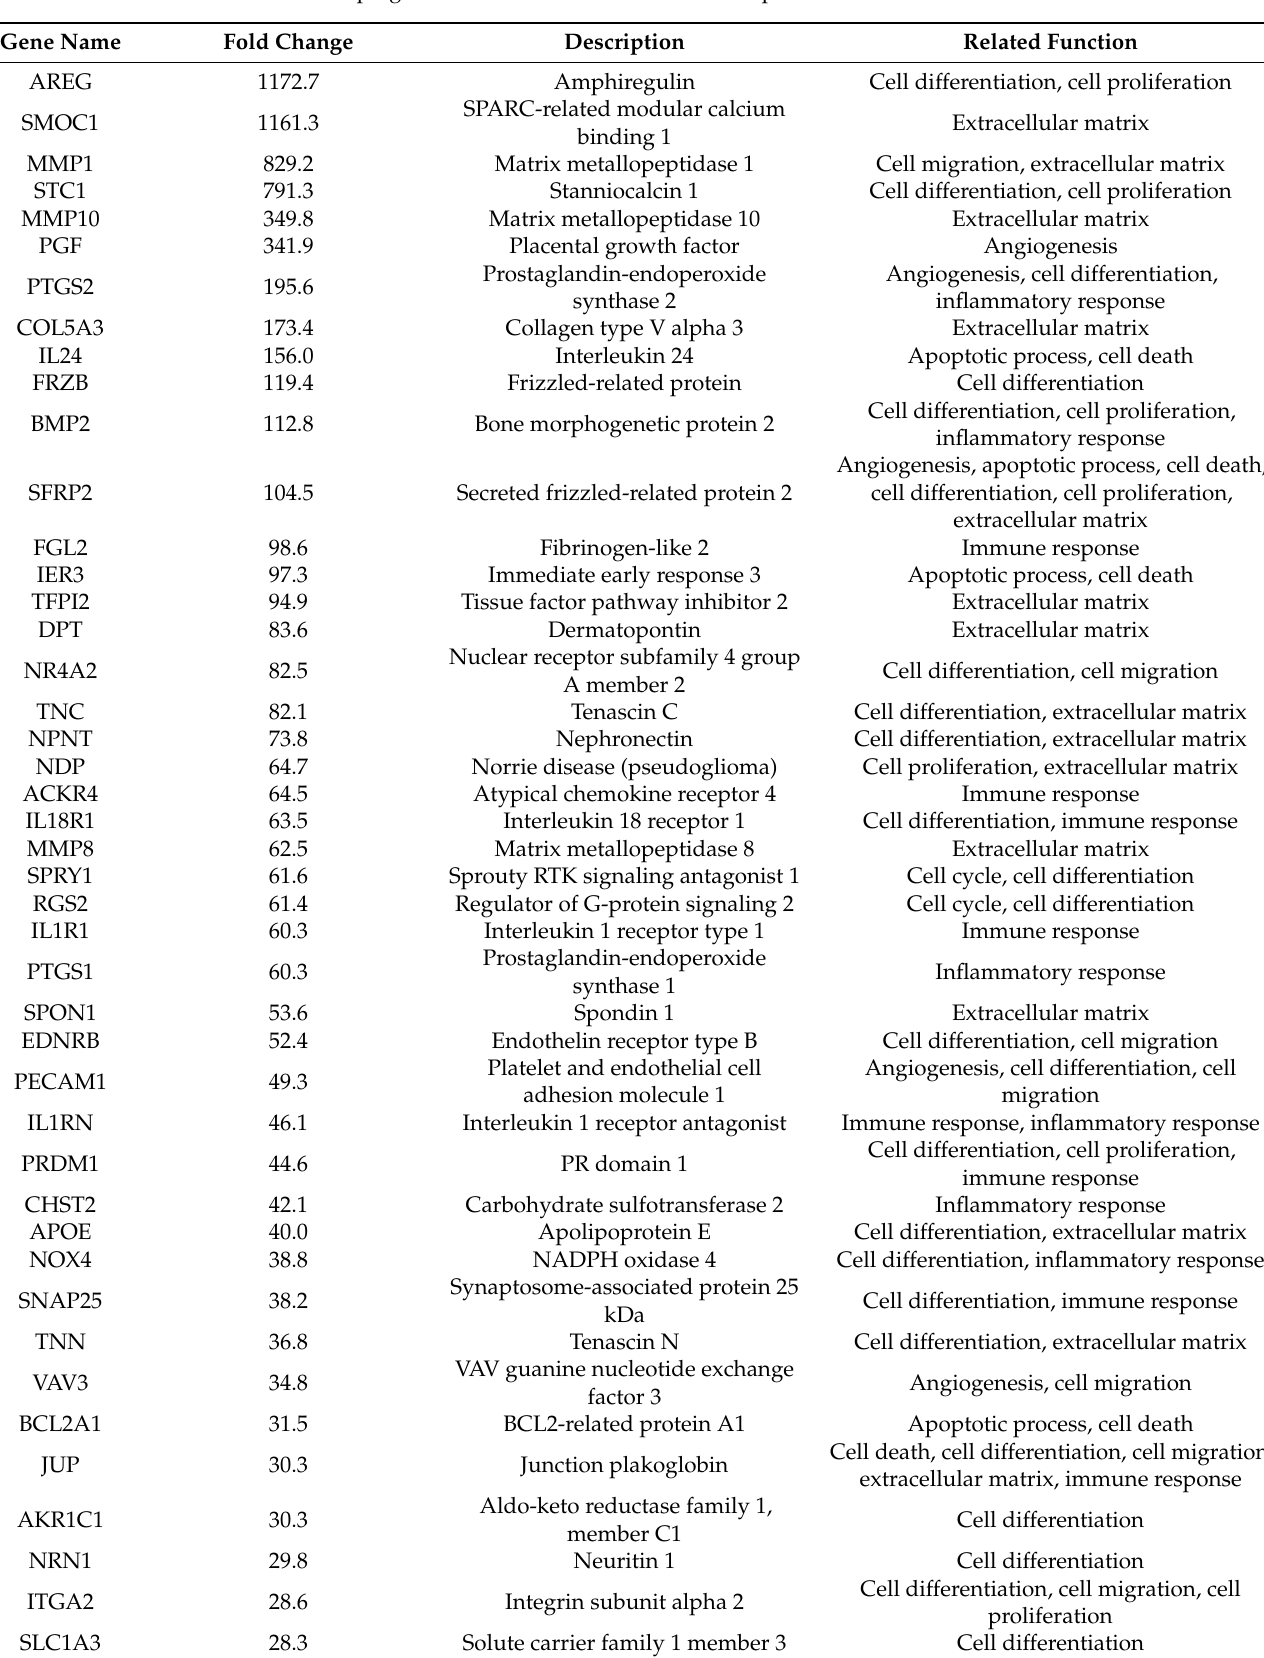
Table 1. Genes upregulated more than 10-fold in 3D- compared to 2D-cultured